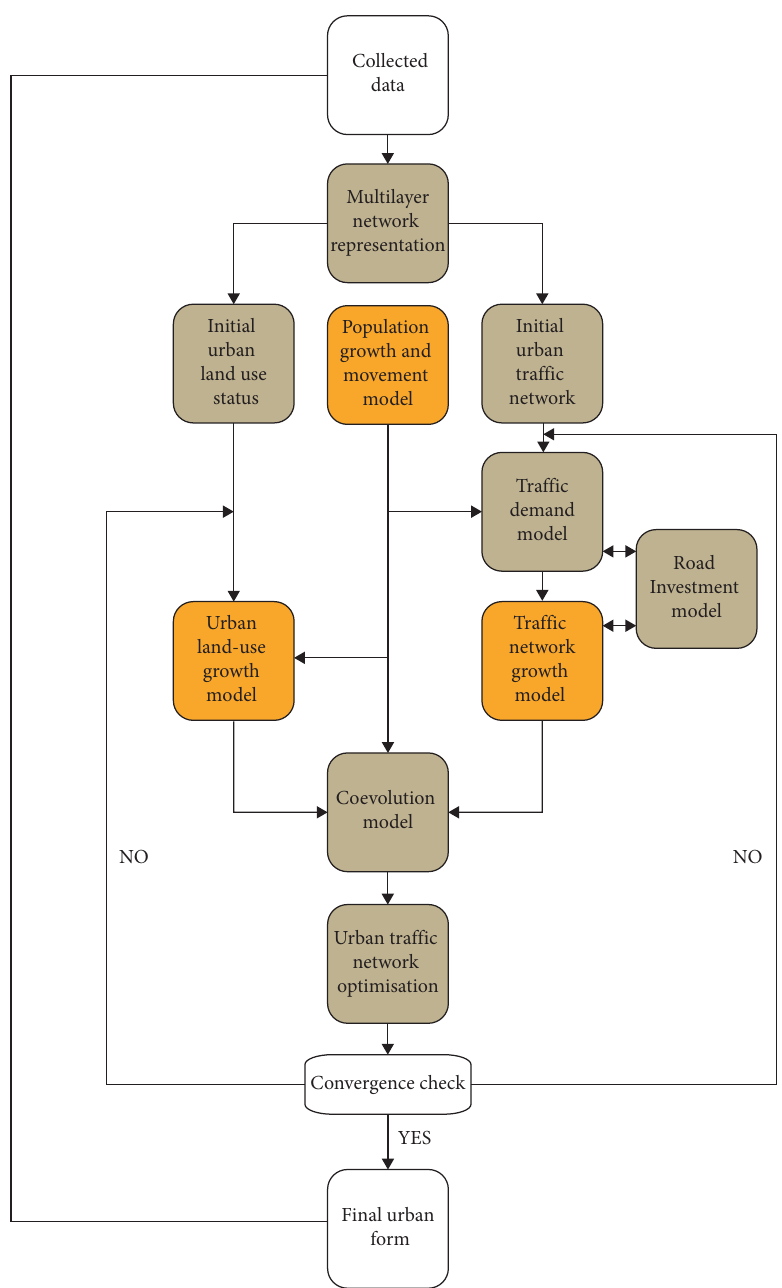
Figure 4: The framework of